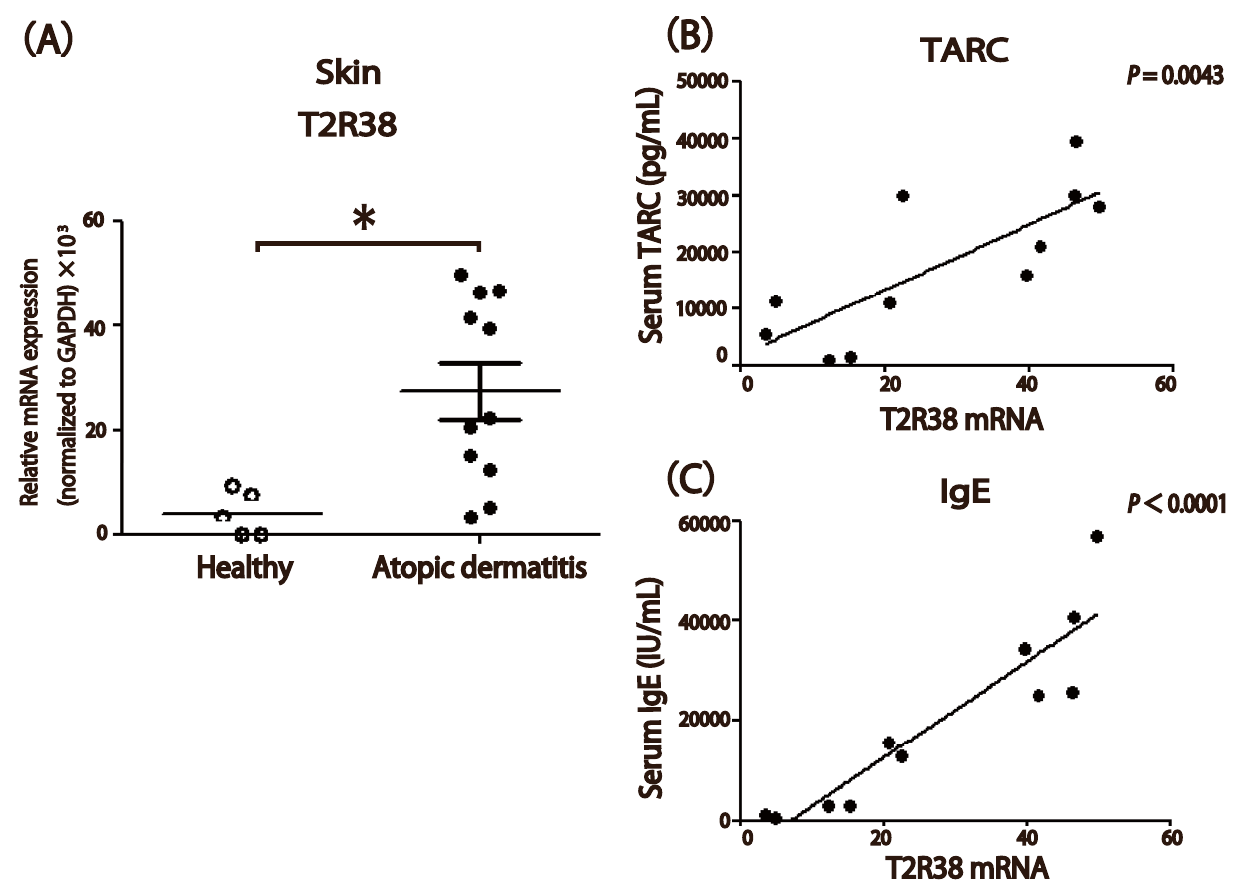
Figure 1. T2R38 expression in atopic dermatitis (AD) skin, and correlation between T2R38 expression levels in lesional skin and serum thymus and activation-regulated chemokine (TARC) or IgE levels in AD patients. ( A ) mRNA expression levels of T2R38 in healthy or AD skin. Skin tissue samples were obtained from 11 patients with AD and five healthy individuals. ( B , C ) Correlation of T2R38 expression levels in lesional skin and serum TARC ( B ) or IgE ( C ) levels in patients with AD. Skin tissue samples were obtained from 11 patients with AD. Significant positive correlation with T2R38 expression levels: TARC (r = 0.7840; P = 0.0043), IgE (r = 0.9171; P < 0.0001). * P < 0.05 by Student’s t -test. The correlation between two groups, in which the data points were distribution-free, was analyzed using the Pearson rank correlation coefficient. We attached row data for GAPDH in PCR assays from skin samples as a supplemental figure (Supplementary Table